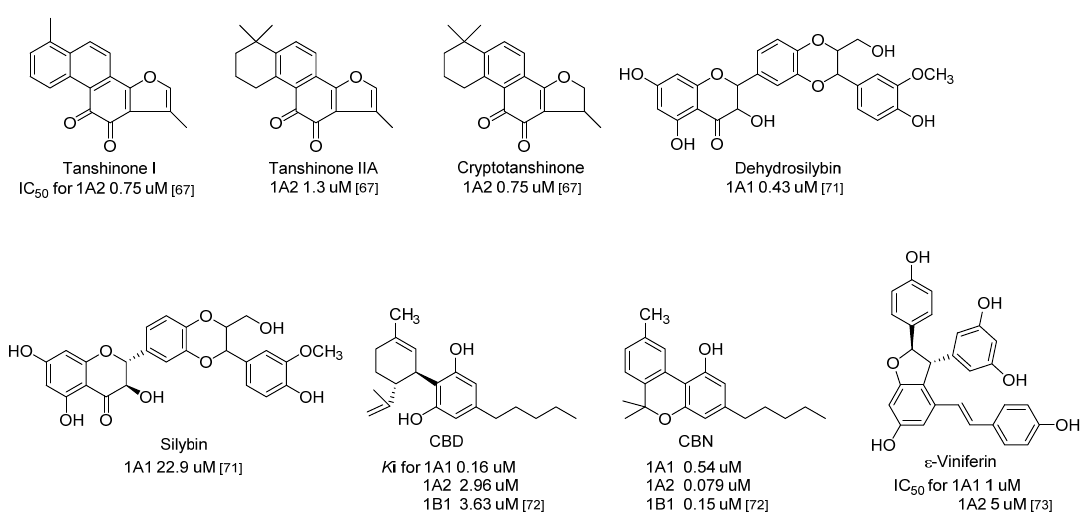
Figure 7. Other naturally occurring products as P450 family 1